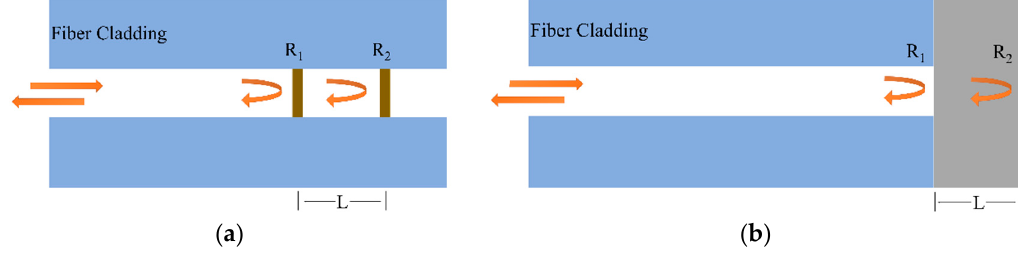
Figure 3. Schematic diagram of ( a ) an intrinsic FPI and ( b ) an extrinsic FPI.